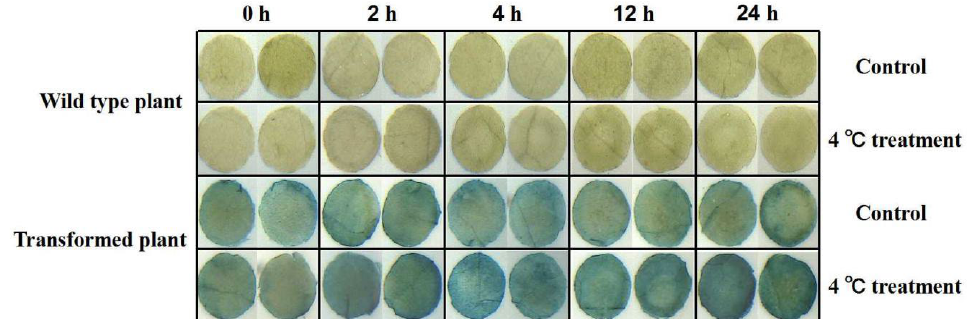
conditions. Tobacco was treated for 0, 2, 4, 12 and 24 h at low temperature (3 replicates per treatment) and then processed into discs (diameter 0.5 cm). The leaf discs that floated under normal growth temperature (25 ◦ C) were used as control.